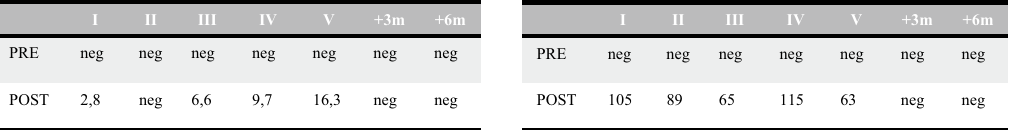
Figure 2. Monitoring of serum ADA ( A ) and drug levels ( B ) pre- and post-procedure during DD cycles. ADA anti-drug